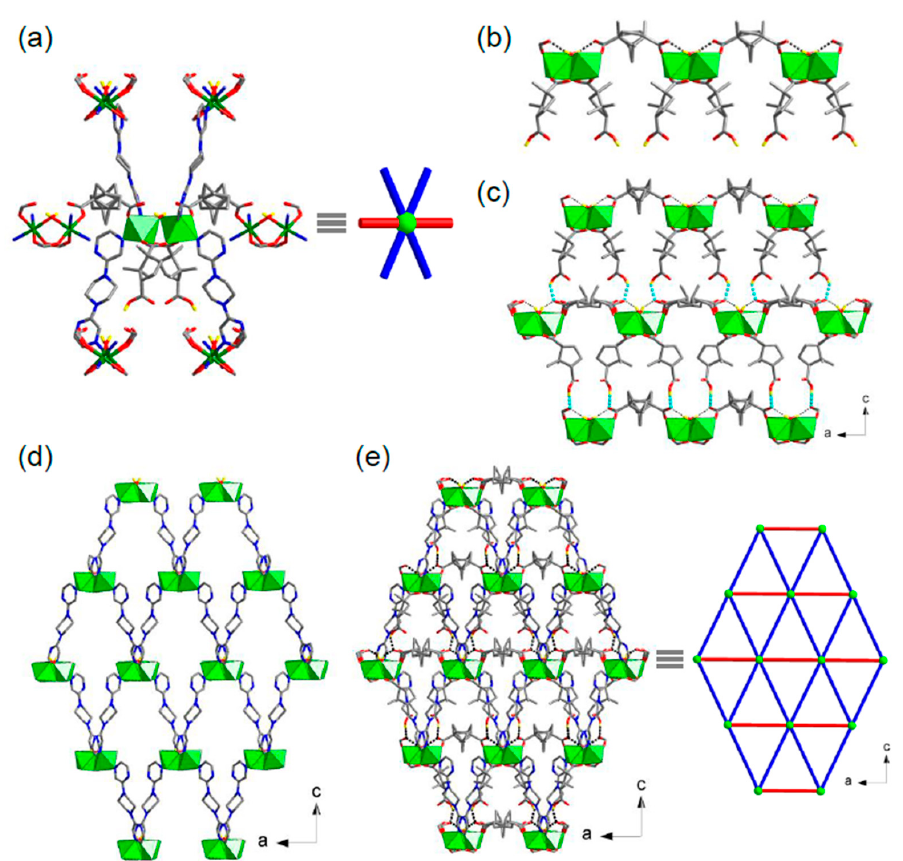
Figure 2. Molecular structure of 1 : ( a ) Water-bridged dinuclear cluster [Ni 2 ( µ -H 2 O)(O 2 C) 4 N 4 ] (green ball) as a topologic six-connected node (red lines: D -cam links; blue lines: bpzpip links); ( b ) The chiral nickel–camphorate coordination chain bound with D -Hcam pendants; ( c ) The 2D chiral nickel–camphorate supramolecular sheet structure supported by chain-to-chain O–H ··· O hydrogen-bonding interactions (cyan dashed lines); ( d ) The achiral nickel–bpzpip (4,4)-sheet; ( e ) The overall 2D layer structure showing uninodal six-connected 3 6 - hxl net topology.